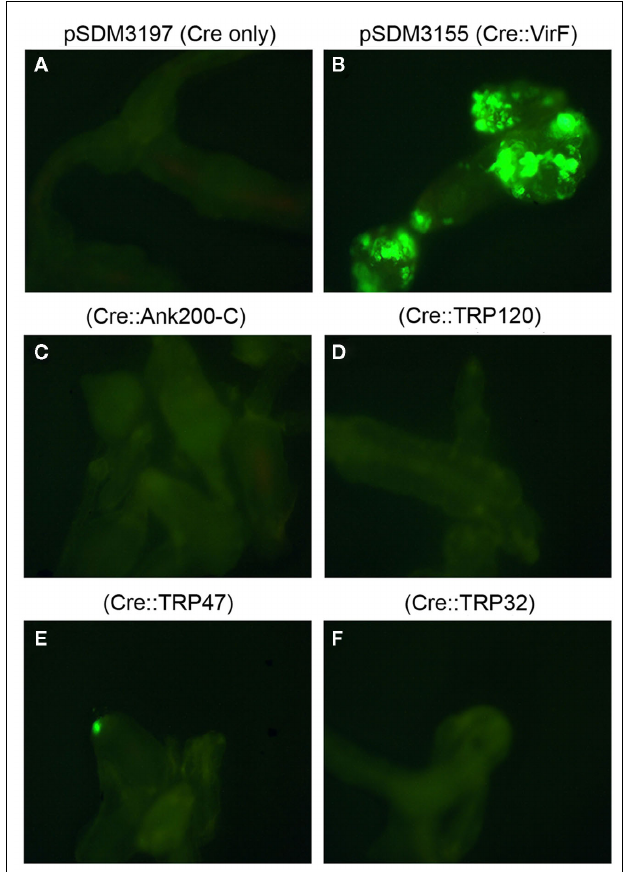
FIGURE 2 |Visualization of protein translocation into host cells using CRAfT assay. Root explants of A. thaliana GFP reporter line CB1 4days after cocultivation with A. tumefaciens wild-type strain LBA1100 containing (A) pSDM3197 plasmid (Cre only, serving as a negative control), (B) pSDM3155 (Cre:VirF, serving as a positive control), (C) Cre::Ank200-C, (D) Cre::TRP120, (E) Cre::TRP47, and (F) Cre::TRP32.Two Petri dishes, each containing at least 200 root explants were used per strain. Fluorescence microscopy was used to examine the GFP marker, which becomes active in CB1 cells after Cre-mediated excision of the blocking sequence, and thus indicates the successful translocation of Cre fusion protein into plant cells.